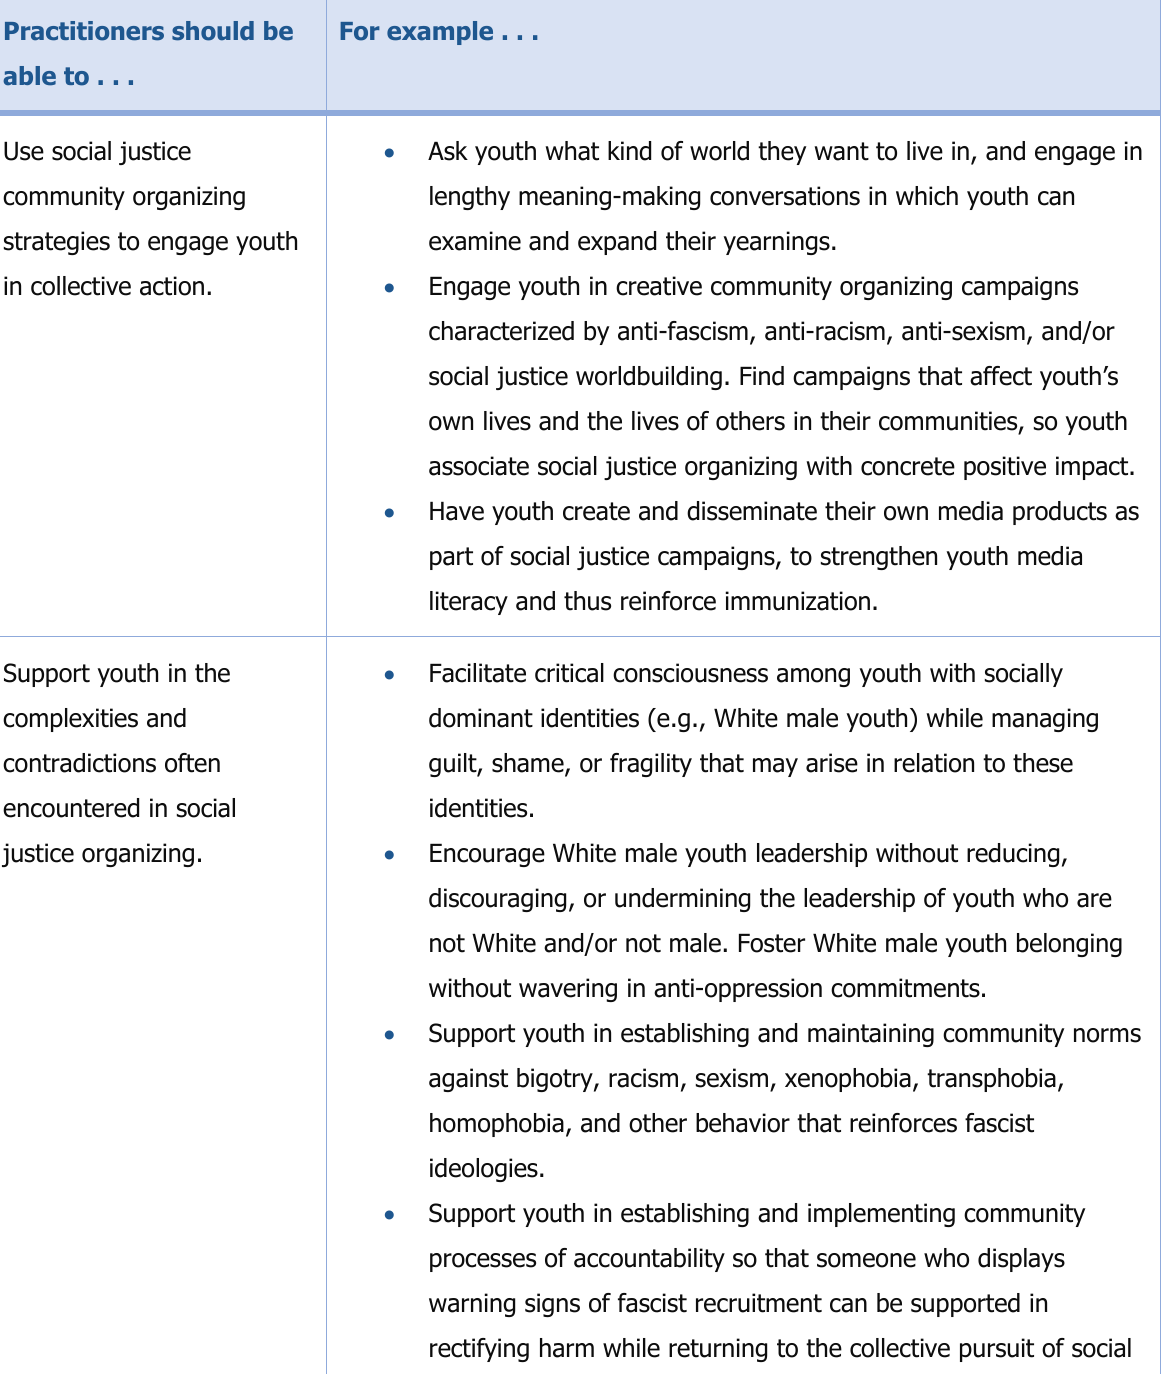
Table 3. Counter-Recruitment Strategies and Examples Practitioners should be able to . .